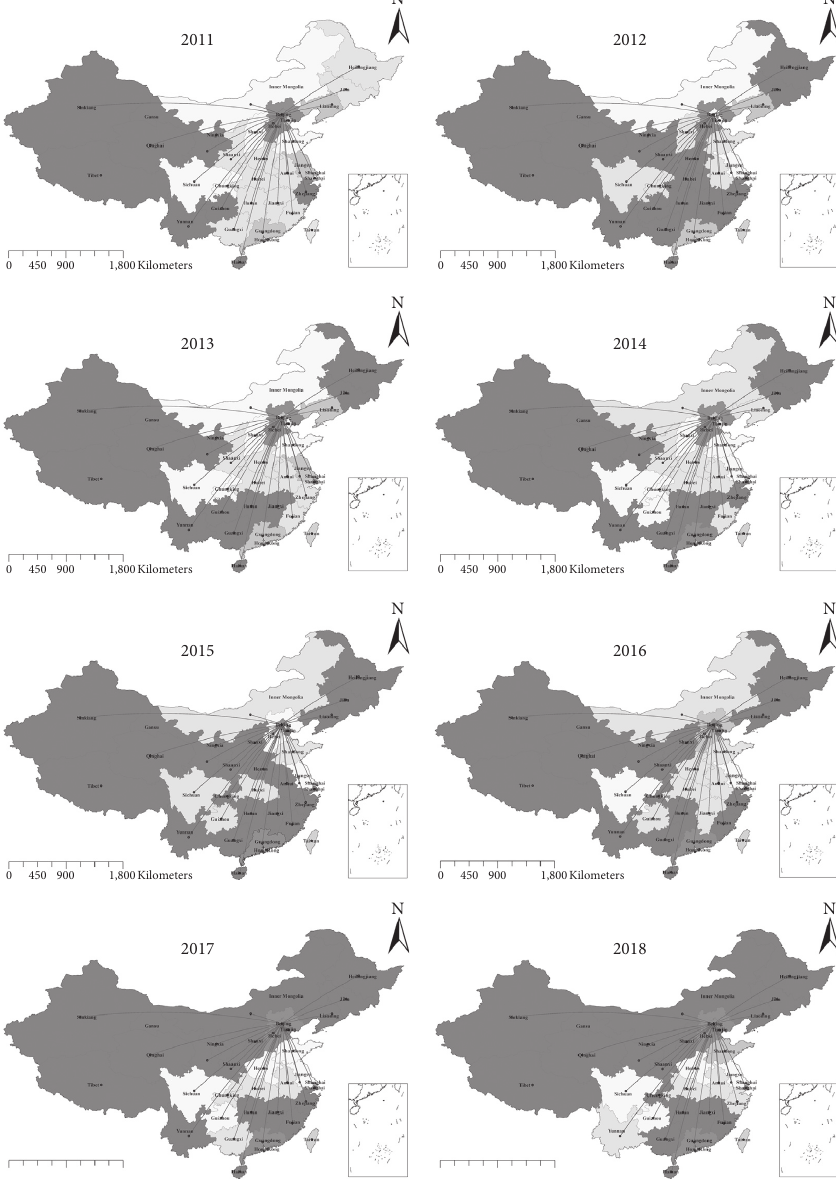
Figure 3: Statistics of the influence degree of Beijing’s construction